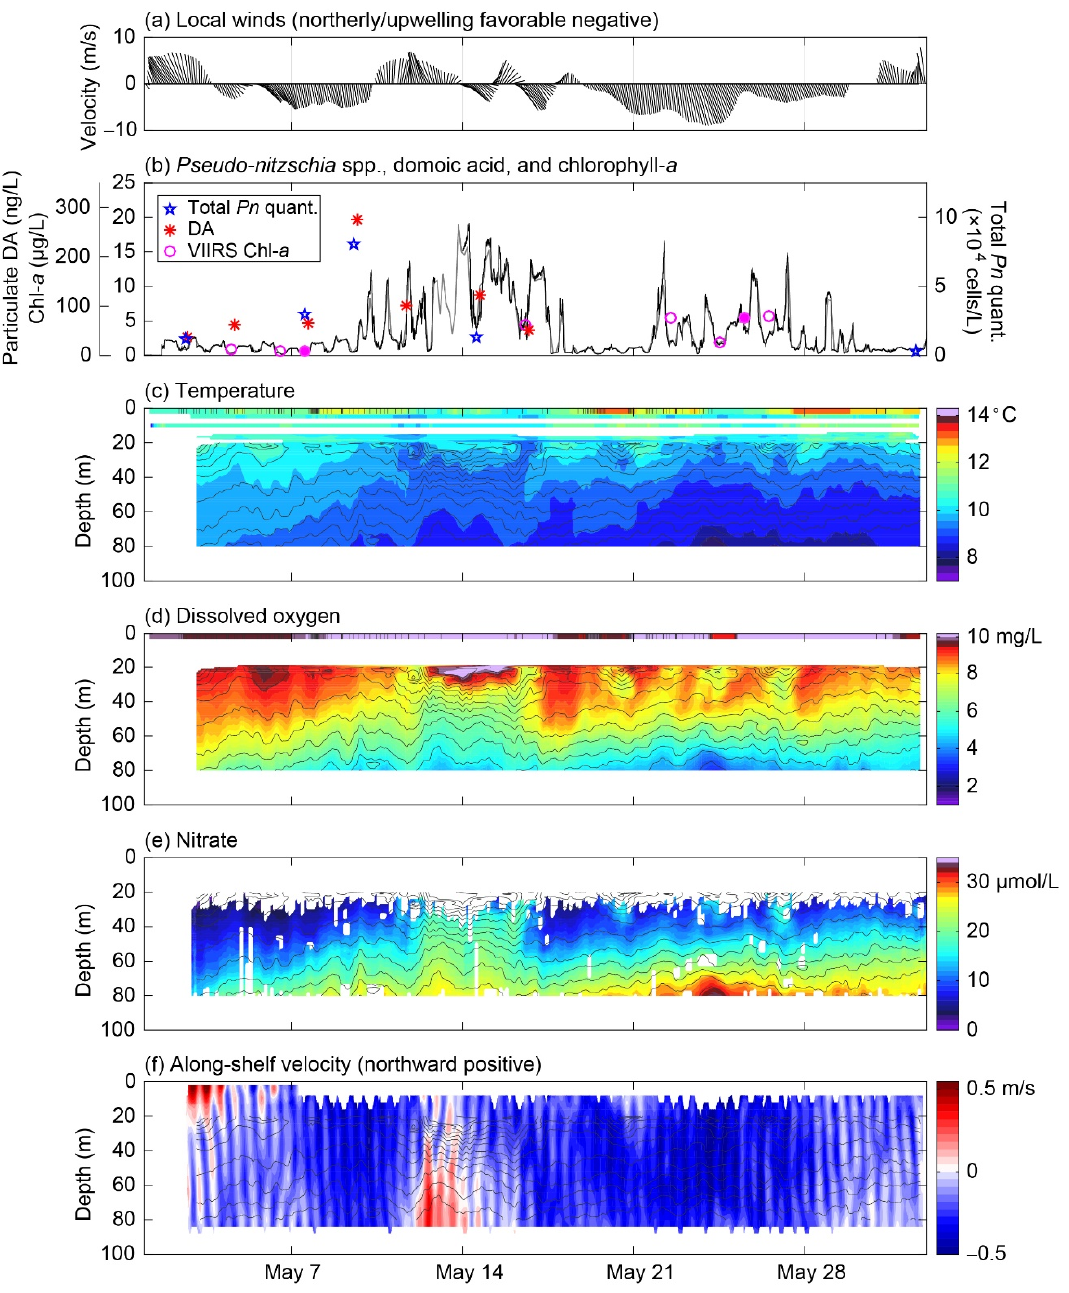
Figure 7. Biological and physico-chemical monitoring results from the ESP mooring and other platforms for the period 1 May to 1 June 2017. ( a ) 12-h smoothed near-surface (4 m) wind velocity vectors from the NDBC Cape Elizabeth buoy (46041), with the along-shelf direction (~345 ◦ T/165 ◦ T) aligned with the vertical axis. ( b ) Two independent measurements of chlorophyll- a concentrations at 1-m depth on the Ch á b ă mooring (gray and black lines). VIIRS chlorophyll- a concentrations at the NEMO location are shown as magenta circles, with filled circles showing the times of satellite images shown in Figure 8. The concentration of particulate domoic acid (DA) in seawater and total abundance of Pseudo-nitzschia spp. quantified during the deployment ( P. australis , P. fraudulenta , P. multiseries , and P. pungens ) are shown as red asterisks and blue stars, respectively. Depth-time maps of ( c ) temperature, ( d ) dissolved oxygen concentration, ( e ) nitrate concentration, and ( f ) along-shelf velocity, with salinity contours overplotted on each, as recorded by the NEMO-SS and Ch á b ă moorings. Times are in Pacific Daylight Time (UTC-7) for all